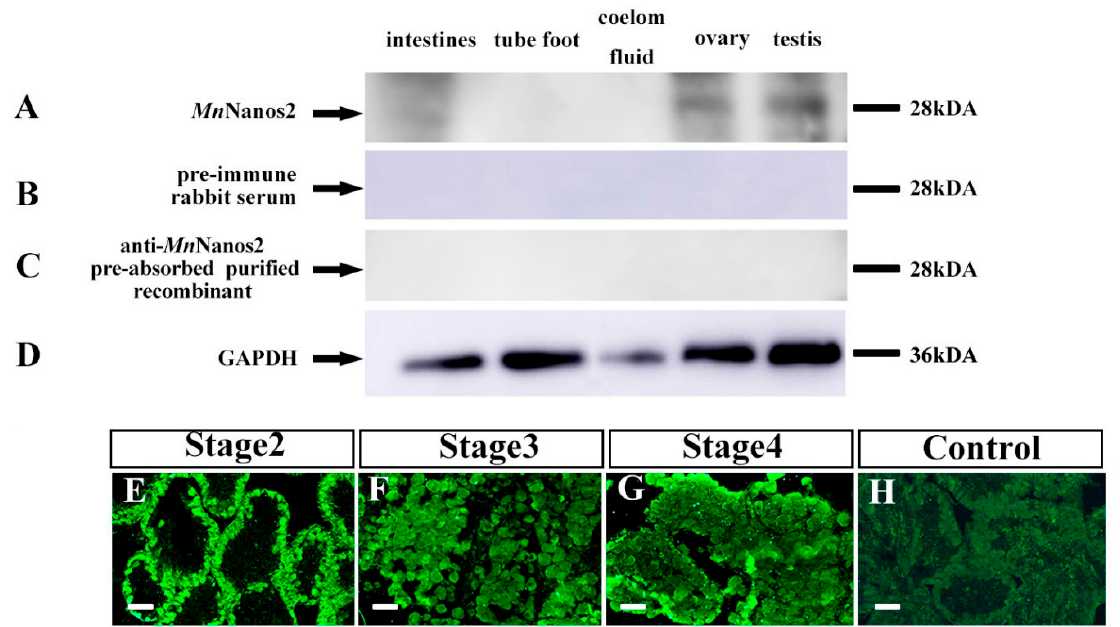
Figure 6. Detection of anti- Mn Nanos2 antibody and immunofluorescence localization of Mn Naons2 in the ovary. ( A ) Western blot with the anti- Mn Nanos2 polyclonal antibody in ovary and testis extracts, ( B ) Western blot with the pre-immune rabbit serum in ovary and testis extracts, ( C ) Western blot with the anti- Mn Nanos2 antibody that had been pre-absorbed with the purified recombinant Mn Nanos2 protein in ovary and testis extracts, ( D ) GAPDH was used as the control, ( E – G ) immunofluorescence localization of Mn Nanos2 in the ovary, ( H ) immunofluorescence localization of pre-immuned serum in the ovary. Bar = 100 µm.